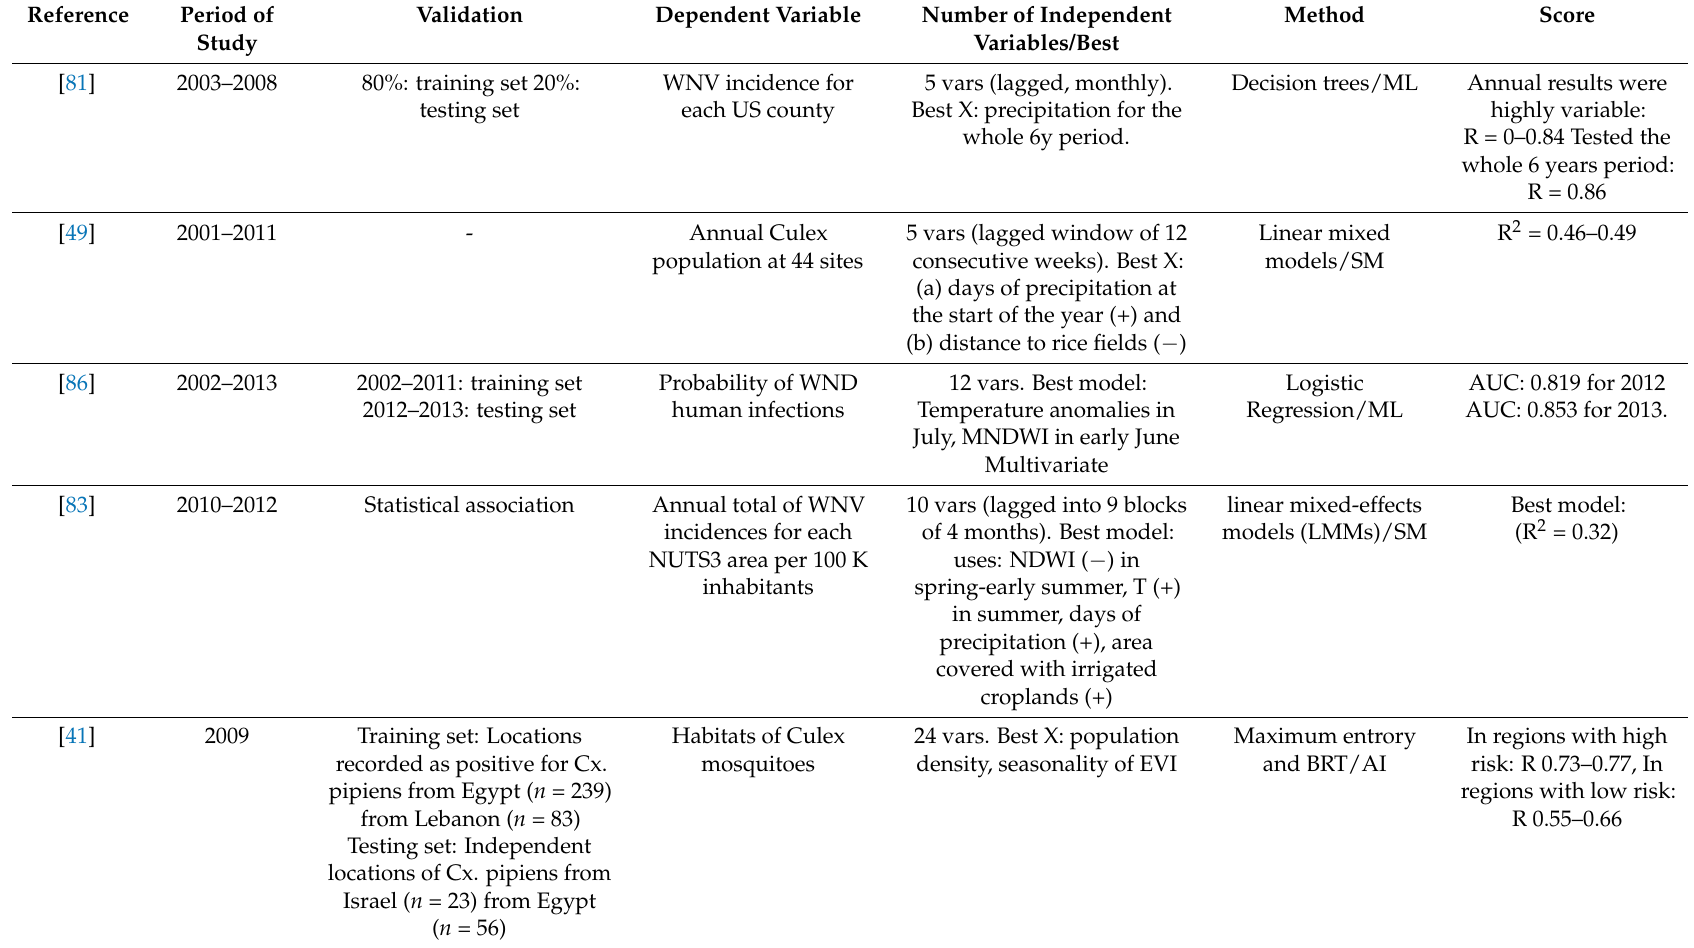
Table A3. Summary table of WNV predictive studies included in review AI: Artificial Intelligence, SM: Statistical